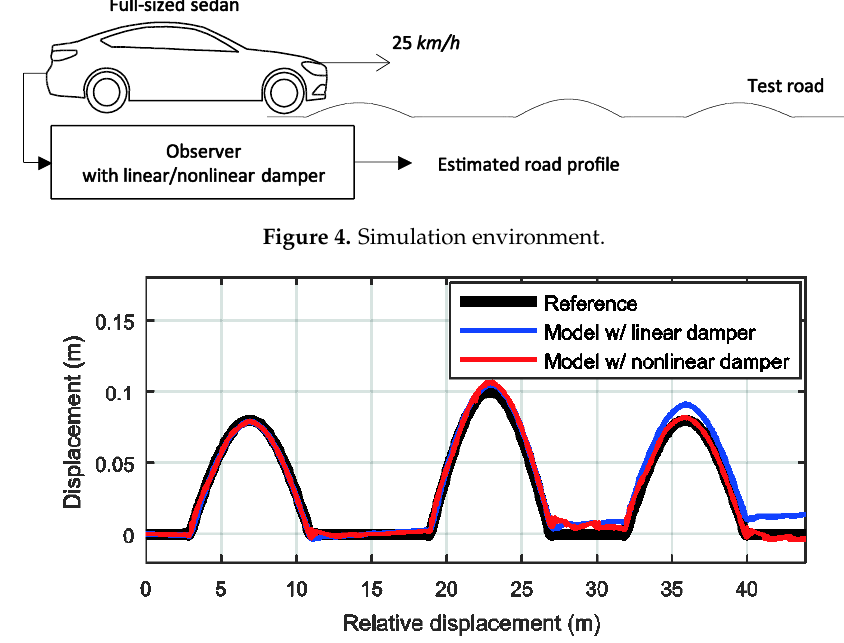
Figure 5. Estimated vertical displacement of front-tire contact patch.